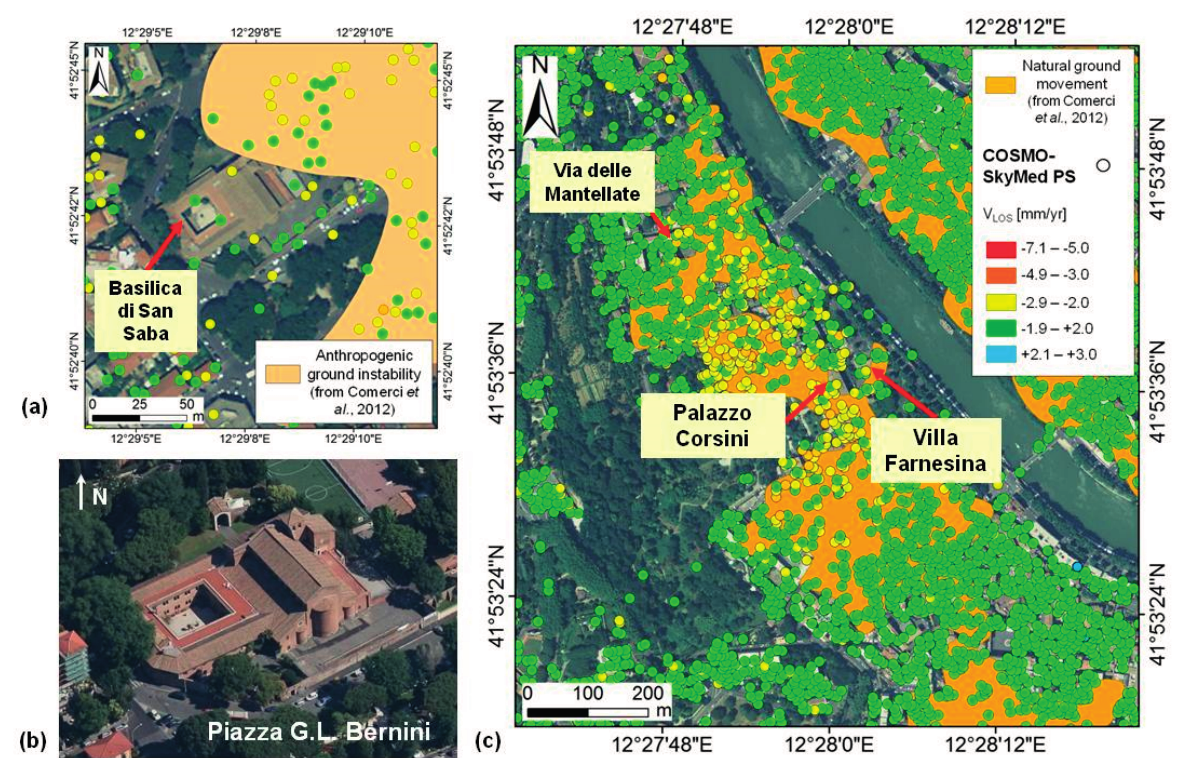
Figure 9. V LOS of the COSMO-SkyMed PS over: ( a ) the Basilica di San Saba; with ( b ) aerial photograph from BingMaps (© 2014 BLOM, © 2014 Microsoft Company); and ( c ) the area of Via delle Mantellate, Trastevere ( cf . Figure 8). Geohazard polygons are from Comerci et al.